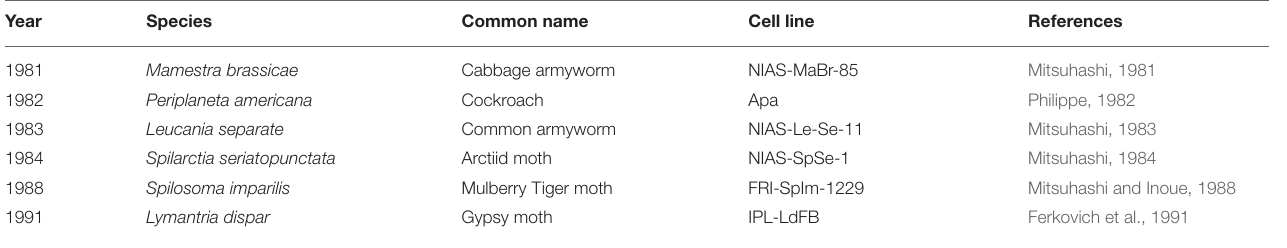
TABLE 3 | Continuous cell lines established from insect fat body